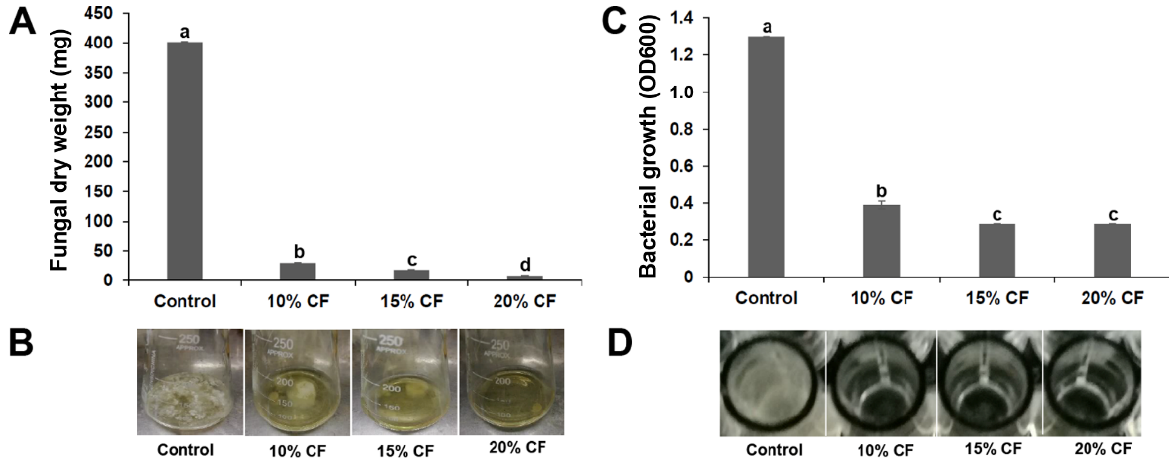
Figure 2. Culture filtrate (CF) of strain XL17 inhibits growth of Botrytis cinerea in potato dextrose broth ( A , B ) and Pseudomonas syringae pv. actinidiae in LB broth ( C , D ). Bacterial growth is indicated by optical density at 600 nm (OD600). The values are mean ± standard error of three replicates for each treatment. Different letters show significant difference at p < 0.05.